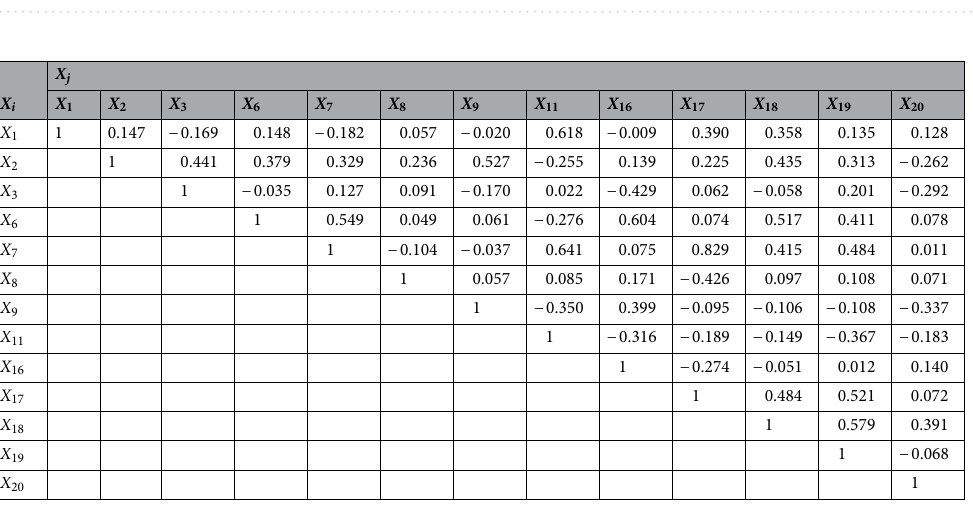
Figure 14. Influence degree of each sub-capability when changing the performance parameters of SARH.